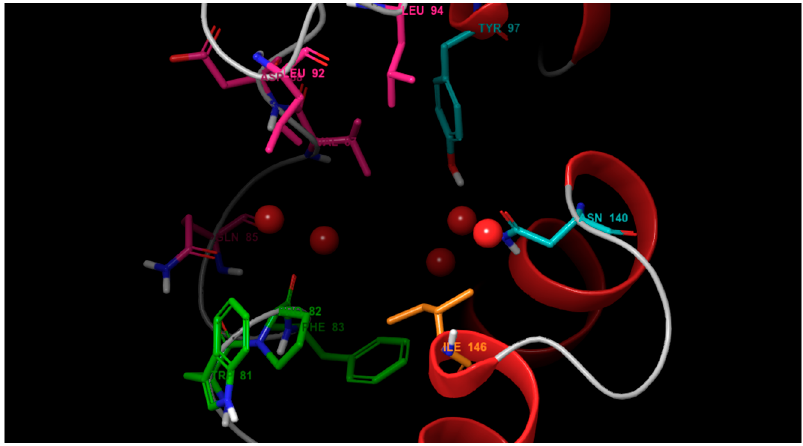
Figure 2. Binding pocket of bromodomain and extraterminal domain (BET) bromomains. The main structural features are the WPF shelf (green), ZA channel (pink), an Ac-pocket (cyan), and the gatekeeper (orange). Red spheres represent structural waters found with BET isoforms.